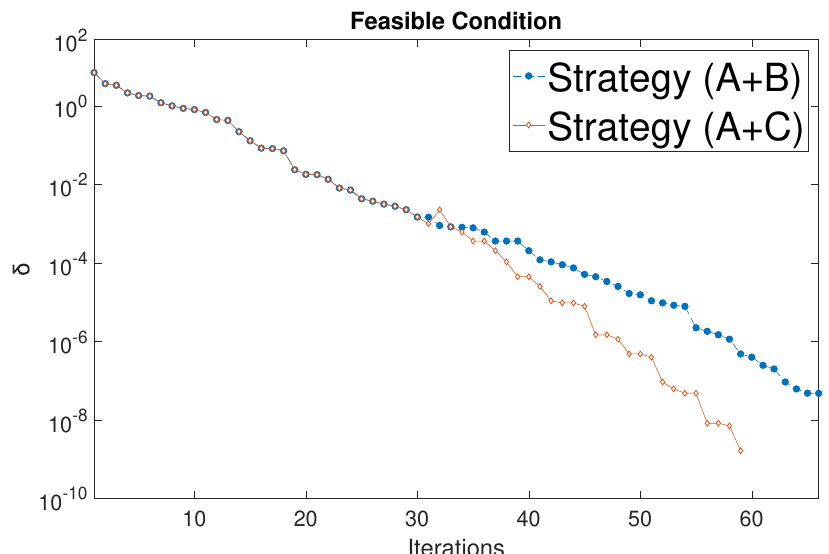
Figure 9. The 30 bus constraints violation. δ is the violations of constraints. Regionalization strategies generated by AR and denote TBS-AR as strategy A, MBS-AR as B and WMBS-AR as C. Strategy A+B (blue line) is the combination of regionalization strategies A and B, Strategy A+C (red line) is the combination of regionalization strategies A and C.